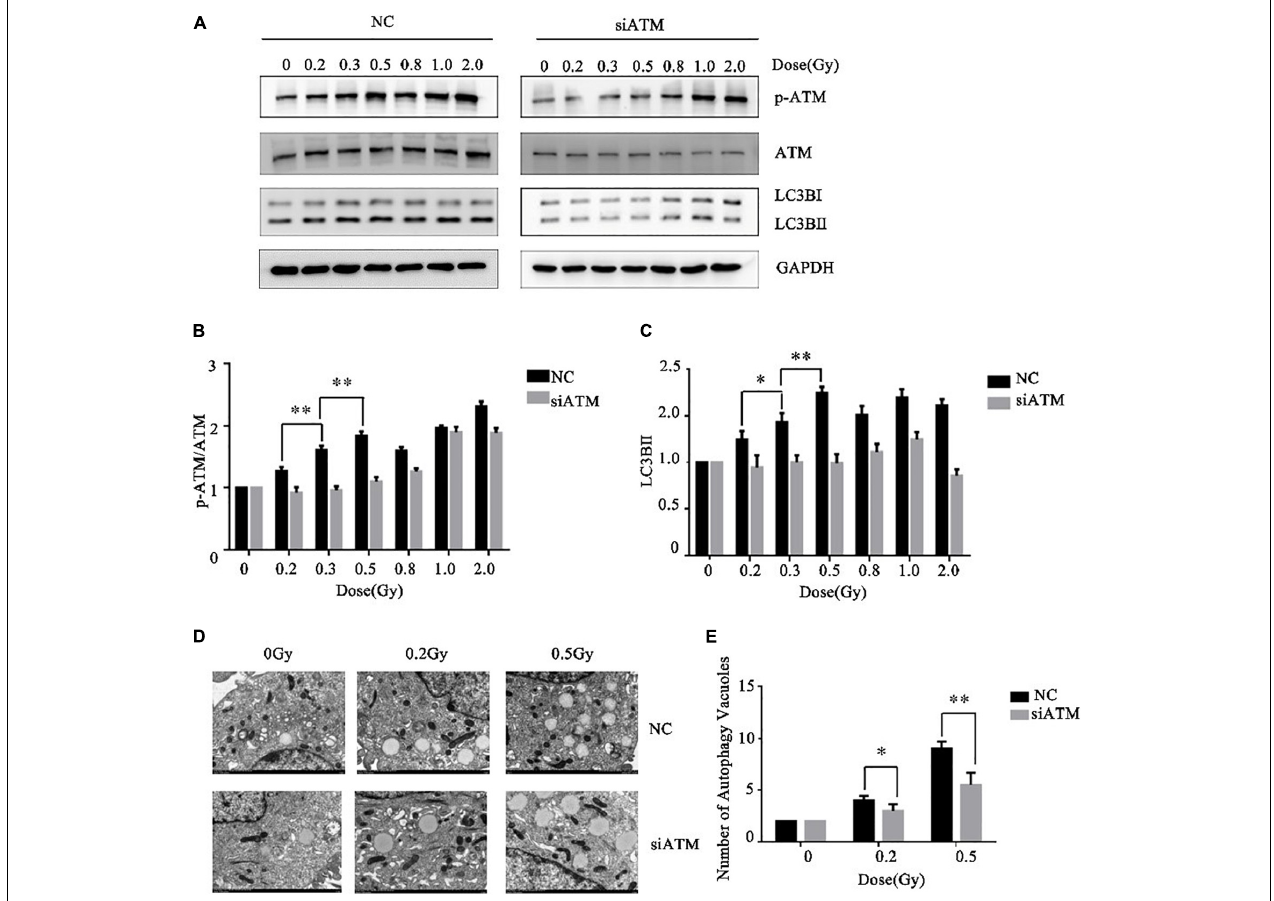
FIGURE 3 | Ataxia telangiectasia mutated (ATM) regulates the level of autophagy in A549 cells after radiotherapy. (A–C) Changes in p-ATM and autophagy levels in the control group and ATM-knockdown group under low-dose radiation were detected by western blot. (D,E) Changes in the number of cellular autophagic vacuoles in the control group and ATM-knockdown group were detected by electron microscopy. ** p < 0.01, * p <